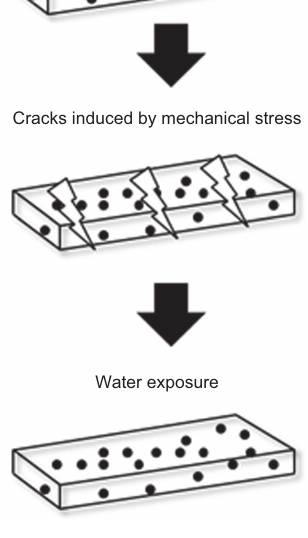
Figure 4 Schematic diagram of the self-healing process of multi- layer hydrogel films with AuNP (redrawn from [31]).